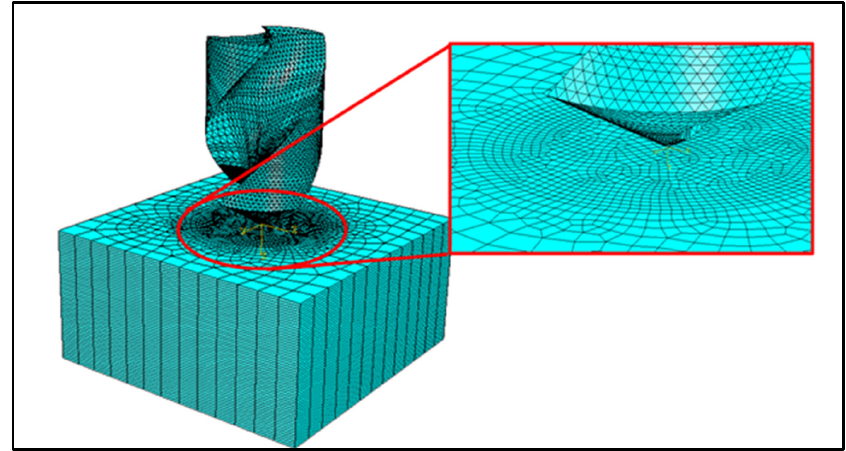
Figure 2. Finite element discretization of the domains.